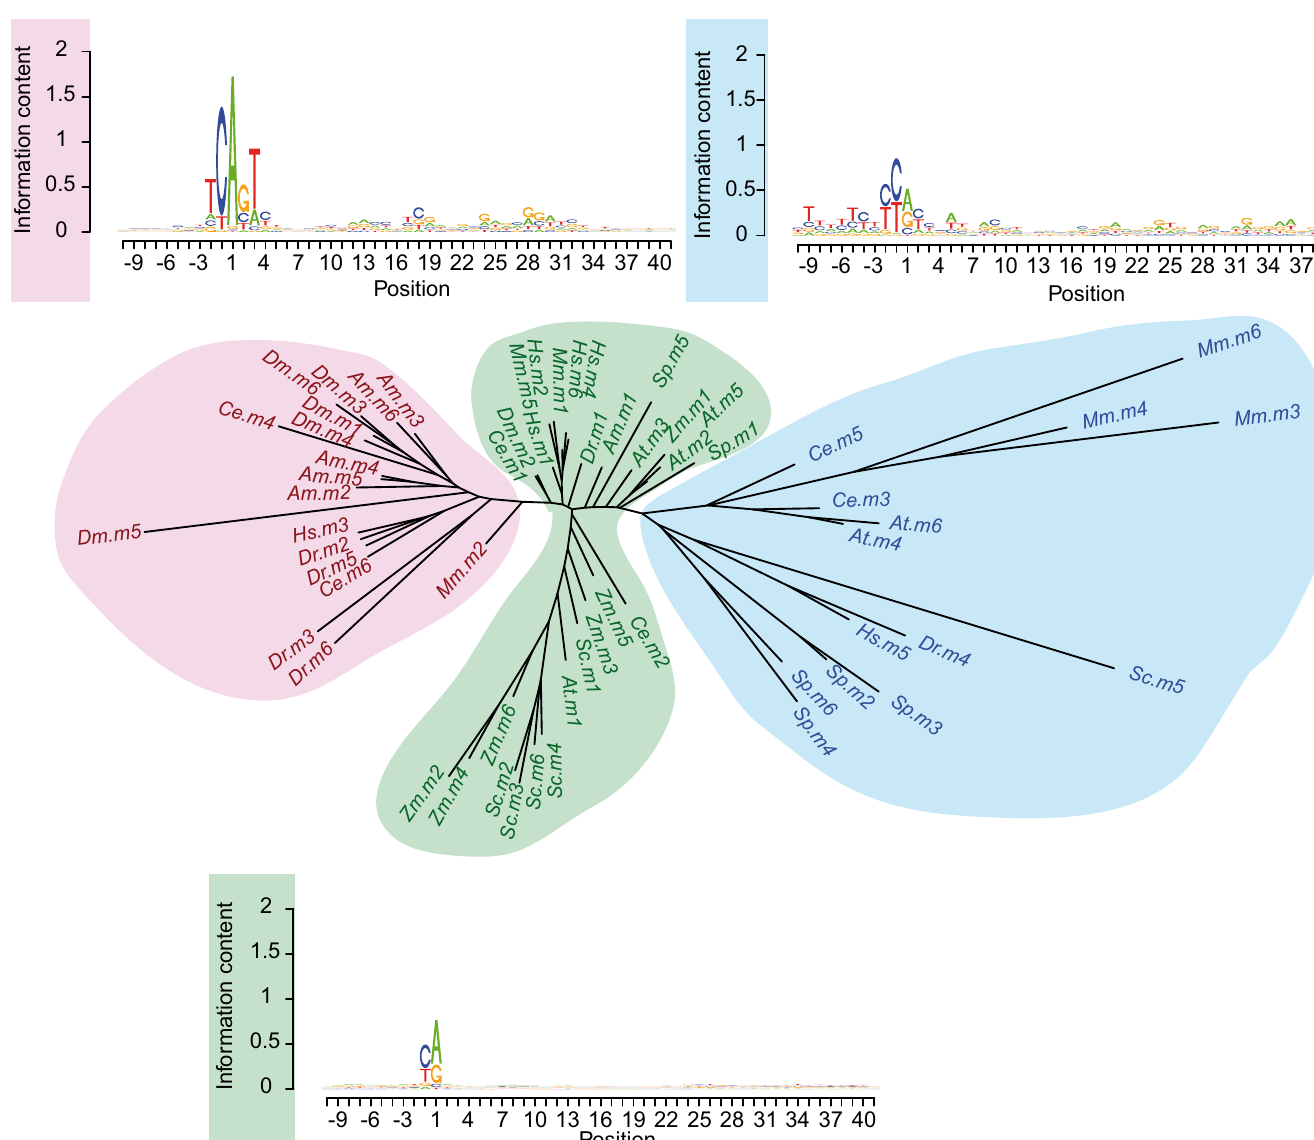
Fig 6. Neighbor joining tree of motifs found in the promoter region of 10 species. Global NJ tree obtained by clustering 6 motifs (identified using the presented EM algorithm, see Methods for detail) in 10 species ( H . sapiens ; M . musculus ; D . rerio ; C . elegans ; D . melanogaster ; A . mellifera ; A . thaliana ; Z . mays ; S . cerevisiae ; S . pombe ). The tree is composed of two main clades (highlighted in red and blue) and a middle ground (green) containing several small branches originating from nodes close to the center. The consensus sequence of each clade is plotted alongside it. The Inr+DPE cluster (red) does not contain plants nor fungi motifs, highlighting the idea that the Inr +DPE element combination is present only in metazoa. The green and blue branches are variations of the basic YR motif.